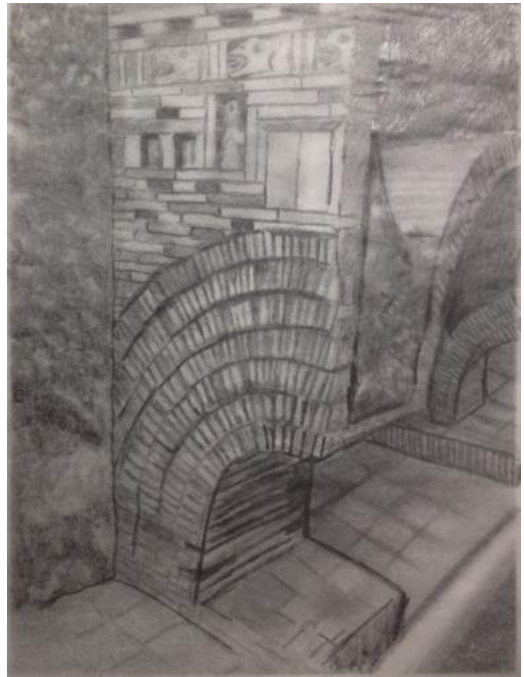
Figure 5. Split view rendering of through screen wall and into front chamber, Jiayuguan M6, Wei-Jin period, 220–317 CE.